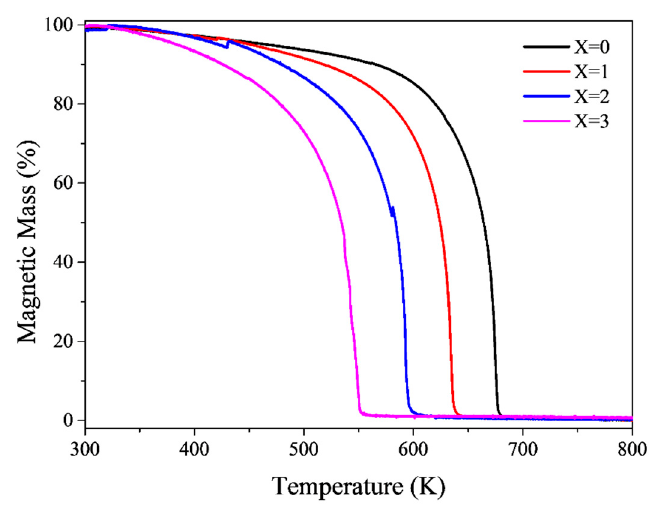
Figure 7. TGA curves of the as-spun Fe 76 Si 9 − x B 10 P 5 Mo x ( x = 0, 1, 2 and 3) ribbons with a heating rate of 10 K/min.